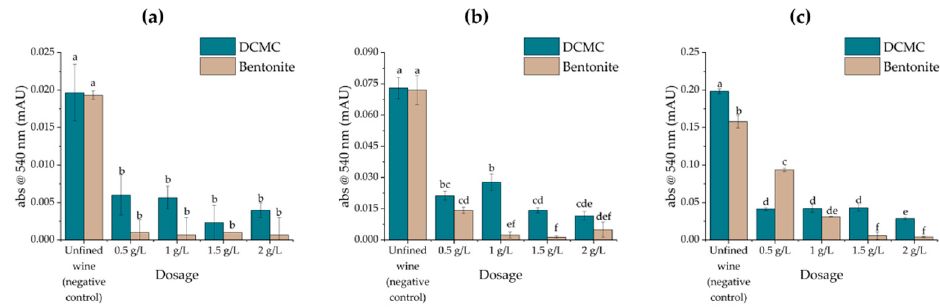
Figure 2. Turbidity (following a HST) of wines treated with increasing amounts of bentonite or DCMC. Different letters represent statistically significative differences among different homogeneous subsets for p = 0.05. ( a ) Encruzado, ( b ) Viosinho, and ( c ) Moscatel de Setúbal monovarietal wines.